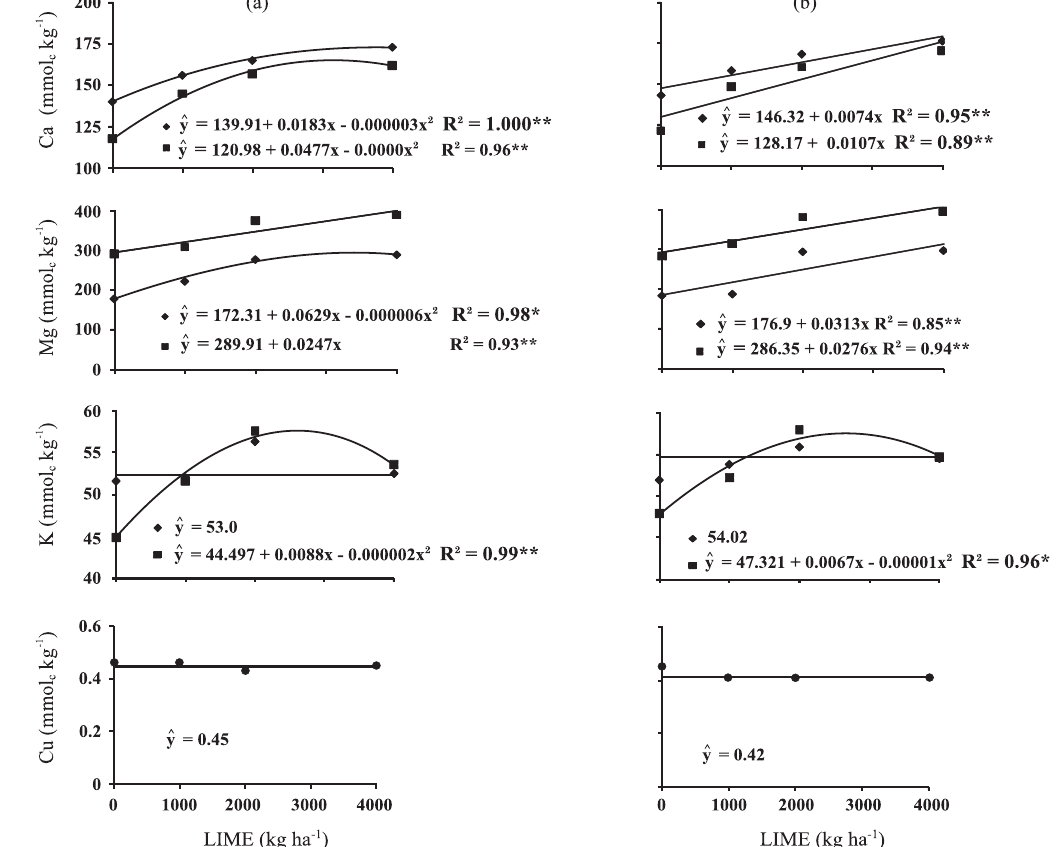
Figure 1. Contents of water-soluble calcium, magnesium, potassium and copper in extracts of flowering peanut as related to surface liming . ( ) mean of the treatments with and without gypsum application, ( ) without gypsum and ( ) with gypsum in 2004/2005 (a) and 2005/2006